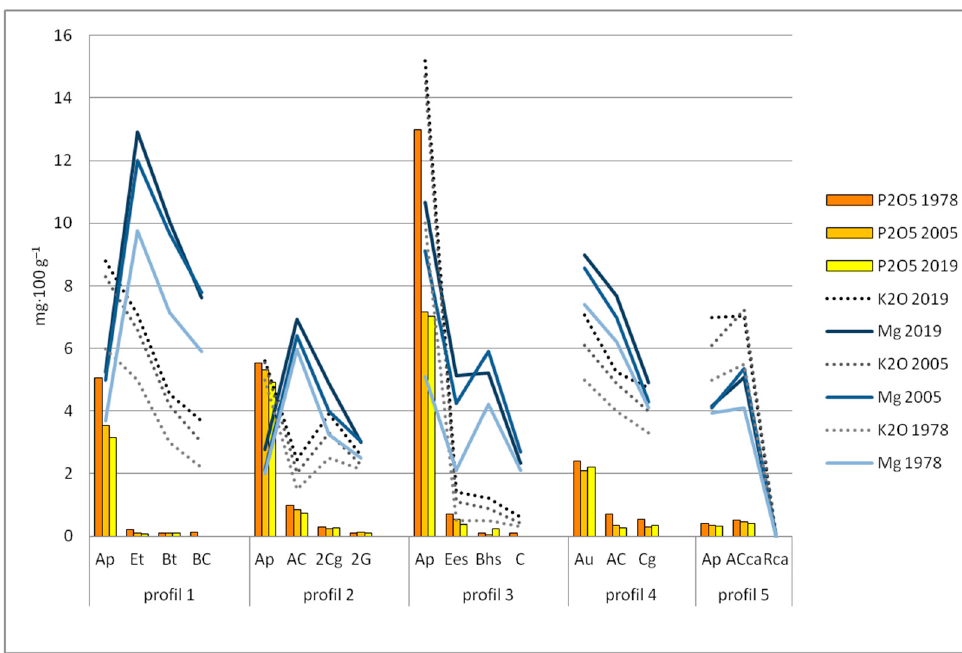
Figure 7. Changes in the content of digestible components (P 2 O 5 , K 2 O, Mg (mg . 100g − 1 )) in various horizons of the analysed soils in 1978–2019.